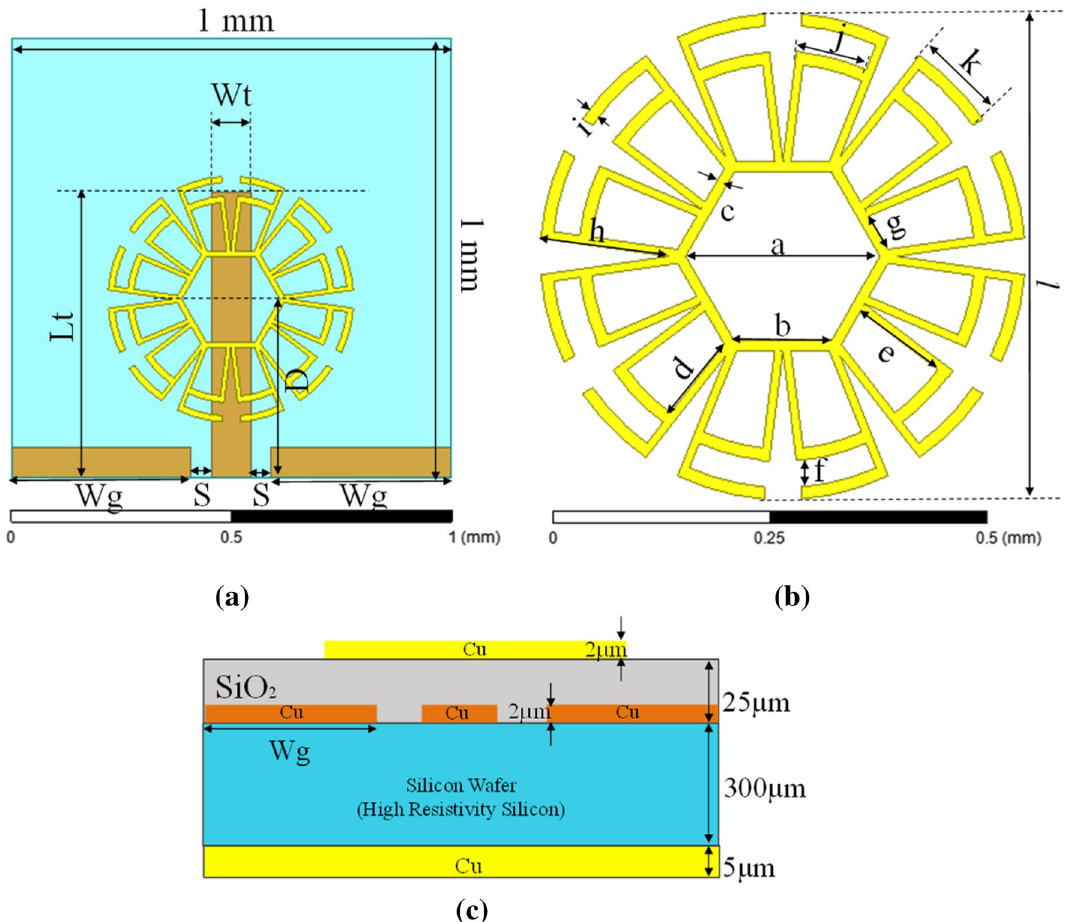
Figure 1. Top view of proposed antenna ( a ) flower-metamaterial antenna and feed line (CPW), ( b ) flower- metamaterial design and ( c ) cross-sectional view of proposed